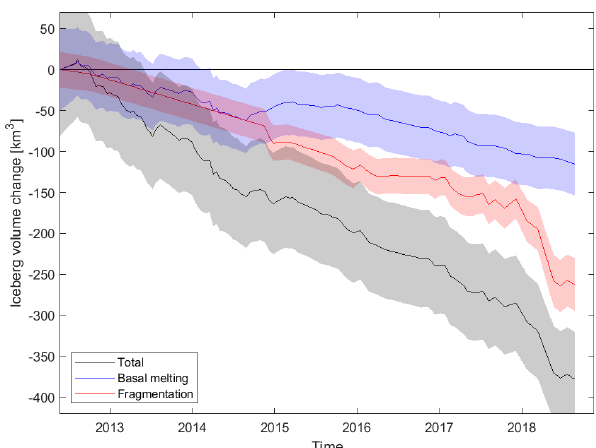
Figure 9. Volume change in the B30 iceberg divided into loss due to basal melting (thickness change, blue) and due to fragmentation (area change, red), as well as total volume loss